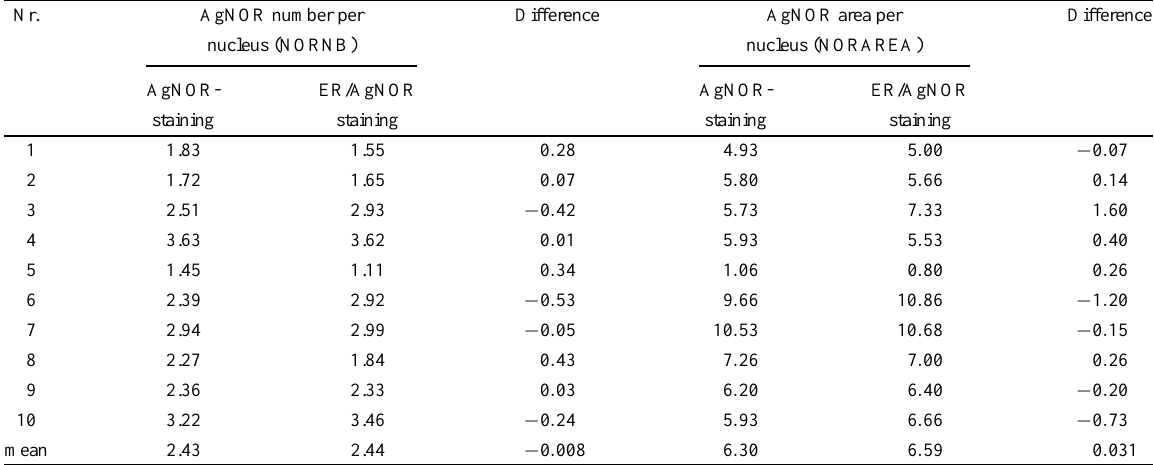
AgNOR number per nucleus (NORNB) and total AgNOR area per nucleus (NORAREA) [ (cid:22) m 2 ] in single AgNOR and ER/AgNOR stained slides